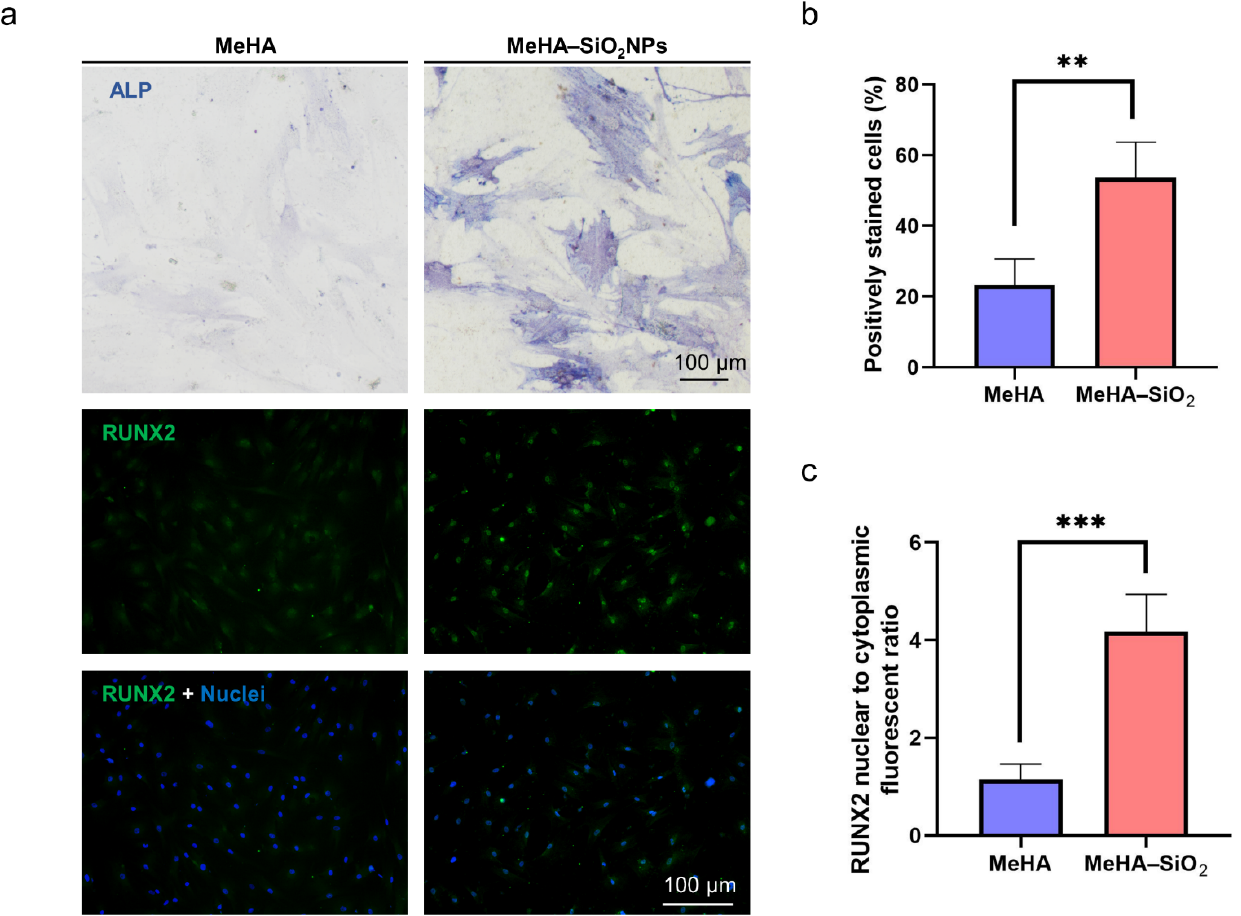
Figure 5. Evaluation of the effect on stem cell differentiation by the soft nanocomposite hydrogel. ( a ) Staining of osteogenic differentiation markers, alkaline phosphatase (ALP) and RUNX2 at the early stage after hMSCs cultured on the hydrogels for 7 d. Statistical analysis of ( b ) the percentage of ALP positively stained cells and ( c ) RUNX2 nuclear localization ratio. The error bars represent the s.e.m. Significance difference p -value: ** p < 0.01, and *** p < 0.001 (one-way ANOVA).